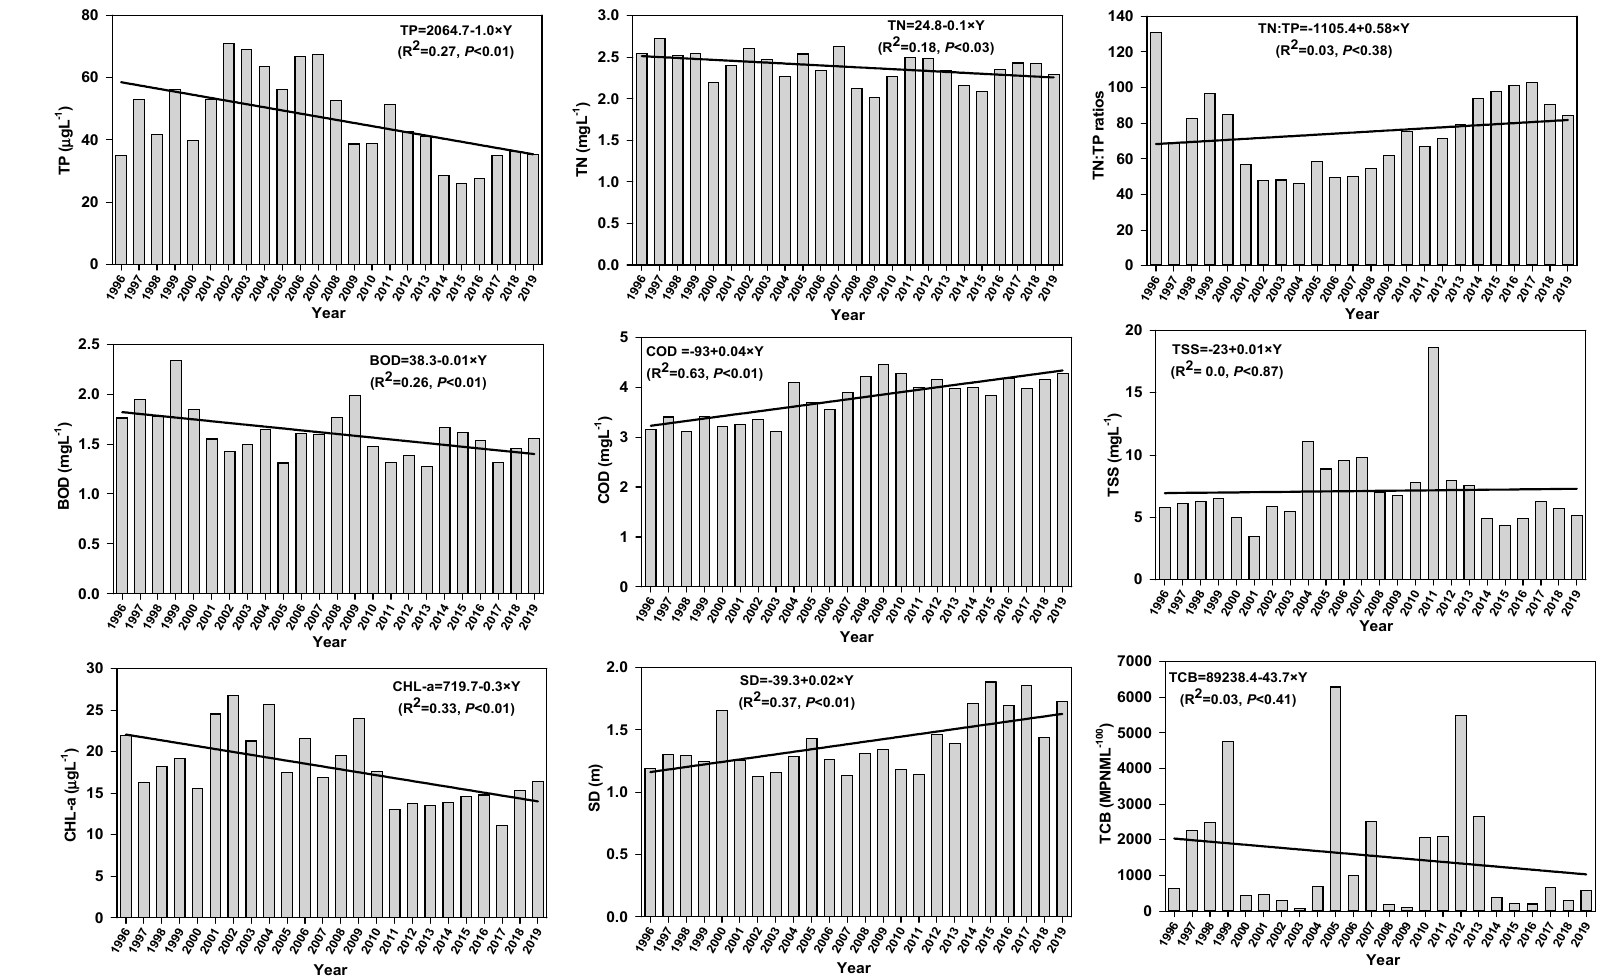
Figure 2. Yearly variation of water quality parameters in Paldang Reservoir. TP—total phosphorus, TN—total nitrogen, BOD—biological oxygen demand, COD—chemical oxygen demand, TSS—total suspended solids, CHL—chlorophyll-a, SD—Secchi depth, TCB—total coliform bacteria.